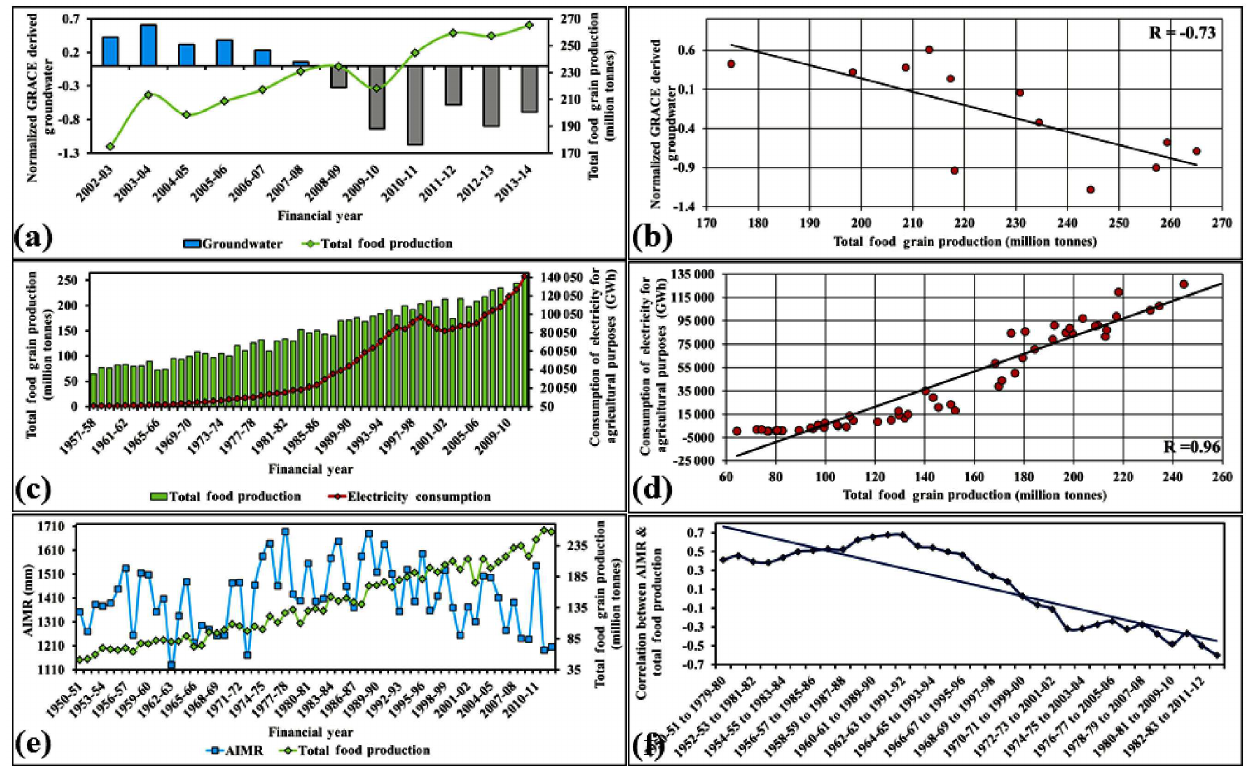
Figure 6. Food security maintained at the cost of decreased groundwater storage and increased electricity consumption. (a) Declining GRACE-derived groundwater storage anomaly and increased total food production. (b) Scatter plot between GRACE-derived groundwater storage anomaly and total food grain production. (c) Increased food grain production and electricity consumption for agricultural pur- poses. (d) Scatter plot between total food grain production and consumption of electricity for agricultural purposes. (e) Trend of AIMR and food grain production. (f) Trend of the correlation between AIMR and total food grain